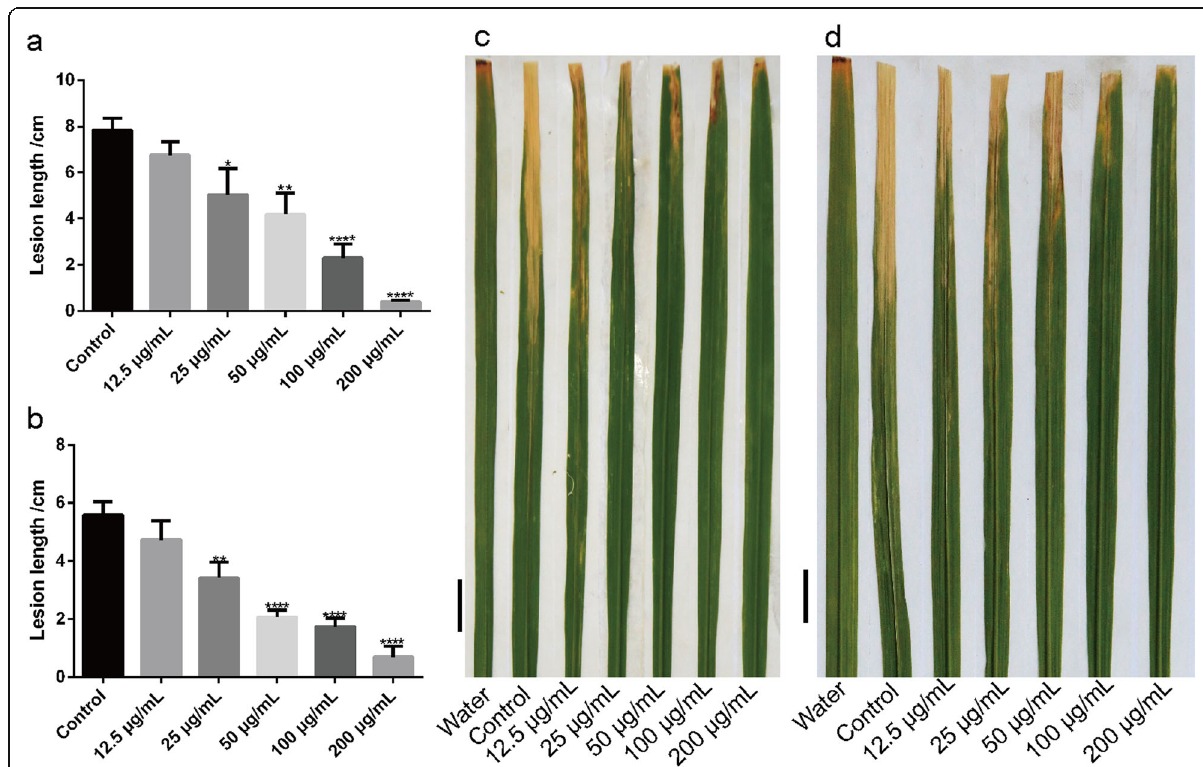
Fig. 6 Protective and curative activities of zinc thiazole against rice bacterial blight. a Lesion length (cm) of PXO99 in rice leaves treated with zinc thiazole: curative test at 7 dpi. Rice leaves were inoculated with Xoo and were sprayed with different concentrations of zinc thiazole (0, 12.5, 25, 50, 100 and 200 μ g/mL) at 12 hpi. b Lesion length produced by PXO99 in rice leaves treated with zinc thiazole: protective test at 7 dpi. Rice leaves were sprayed with different concentrations of zinc thiazole (0, 12.5, 25, 50, 100 and 200 μ g/mL) and were inoculated with Xoo after 12 h. c Symptom development of Xoo -inoculated leaves in the zinc thiazole curative test at 7 dpi. d Symptom development of Xoo -inoculated leaves in the zinc thiazole protective test at 7 dpi. Bar = 1 cm. Xoo -inoculated leaves were used as a positive control, and leaves treated with water (containing 0.1% DMSO) were used as a negative control. Error bars represent standard errors from three independent replicates. *: P < 0.05; **: P < 0.01; ****: P <